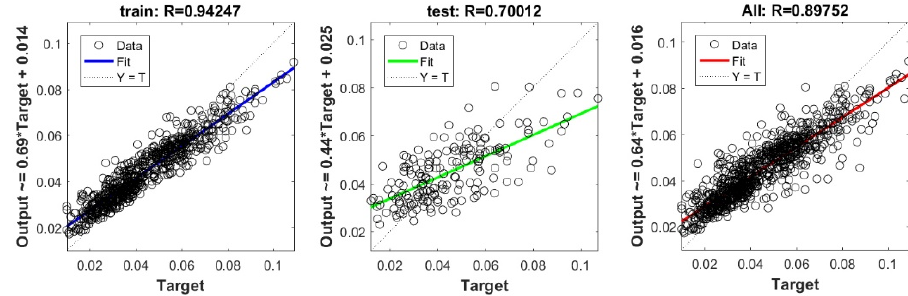
Figure A27. Scatter plots between target and output value by the PSO-RF model.